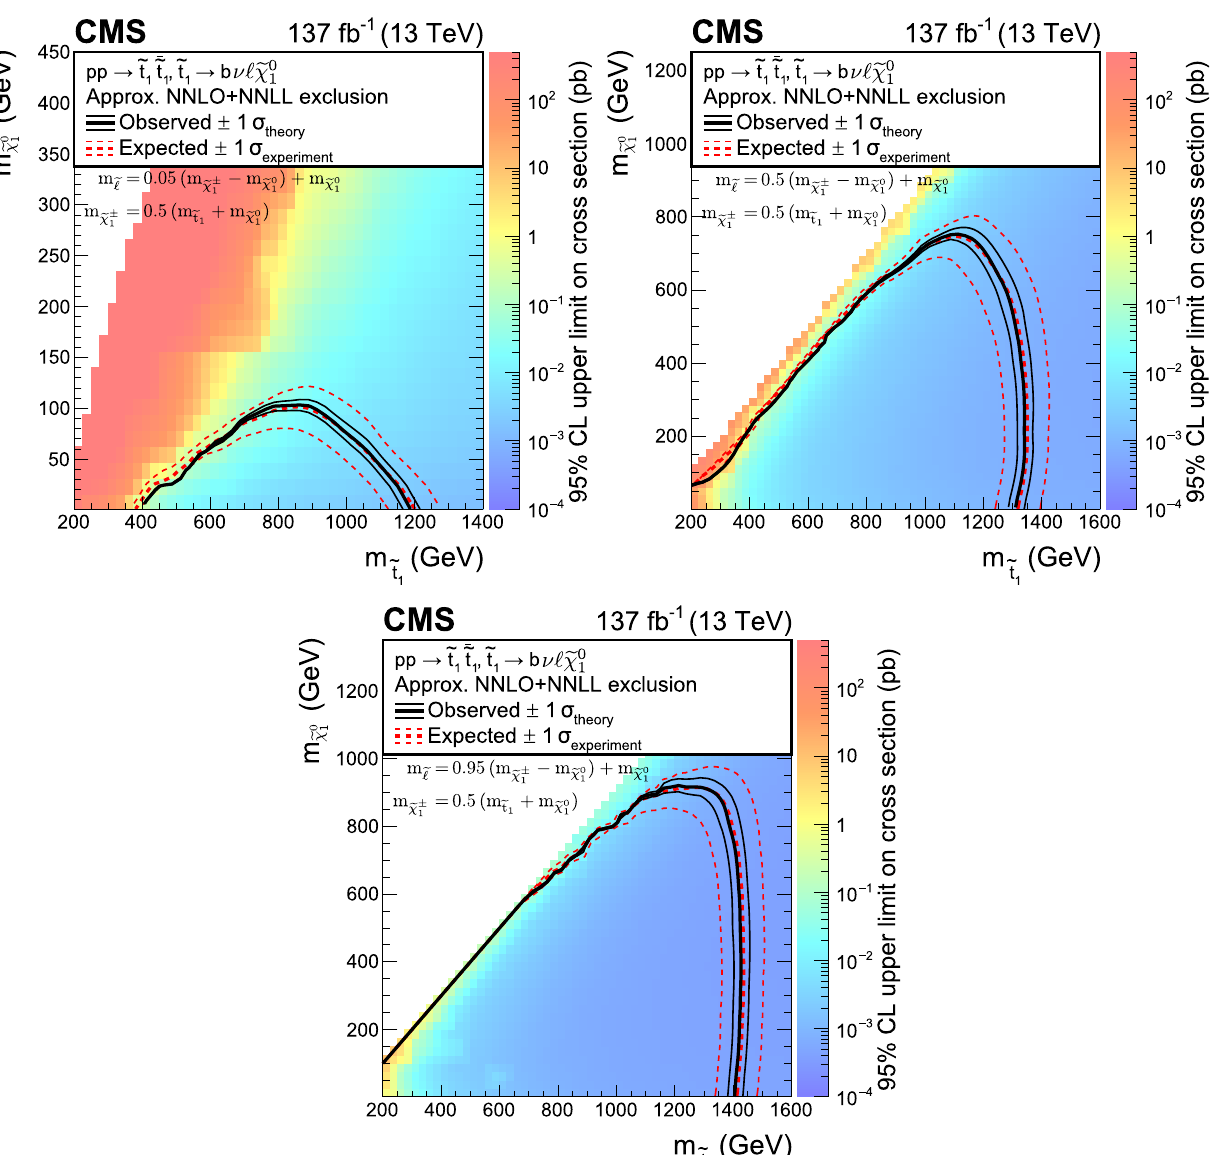
Fig. 7 Expected and observed limits for the T8bb (cid:5)(cid:5)νν model with ˜ t → b ˜ χ + → b ν (cid:2) (cid:5) → b ν(cid:5) ˜ χ 0 1 1 three different mass configurations defined by m (cid:2) (cid:5) = x ( m ˜ χ +